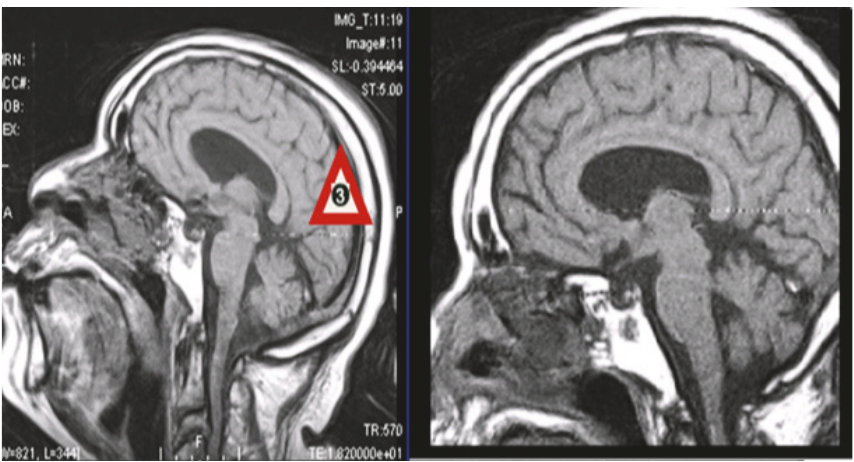
Figure 1: Sagittal T1 diffusion weighted MRI showing a complete opacification of the left sphenoid